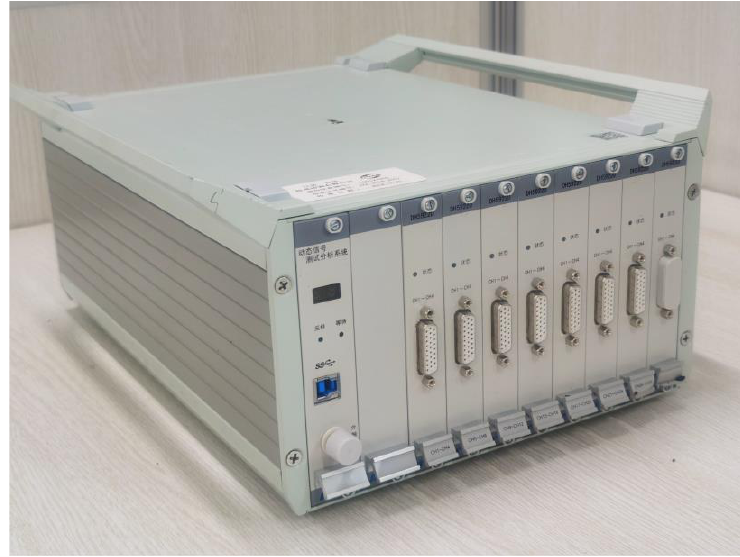
Figure 27. DH5922D dynamic signal tester.